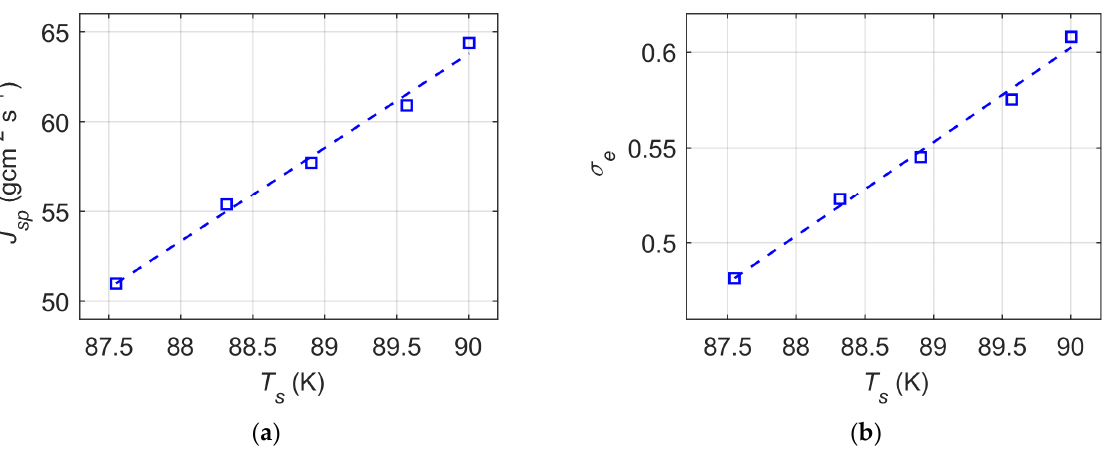
Figure 9. ( a ) The spontaneous evaporation rate, and ( b ) the corresponding evaporation coefficient as functions of liquid surface temperature in steady-state vacuum simulations.